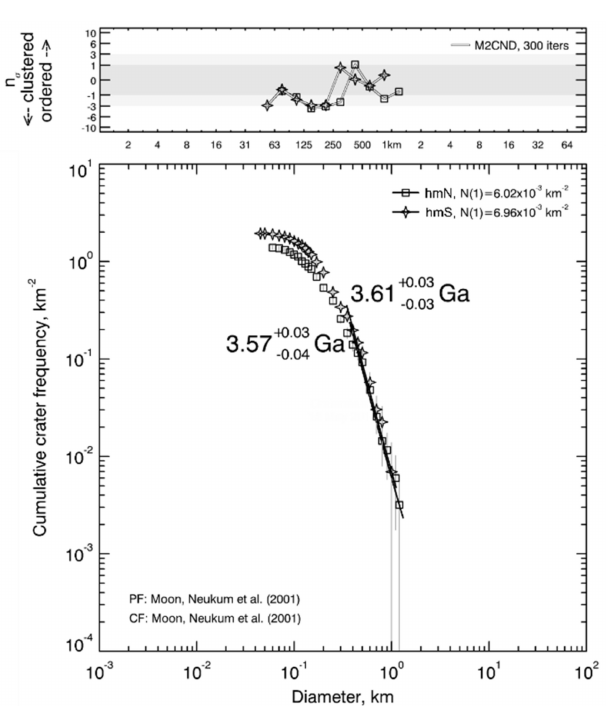
Figure 6. Crater size–frequency distribution (CSFD) measurements performed on hummocky areas for determining the formation age of Tsiolkovskiy. The randomness analysis results are shown in the panel above the